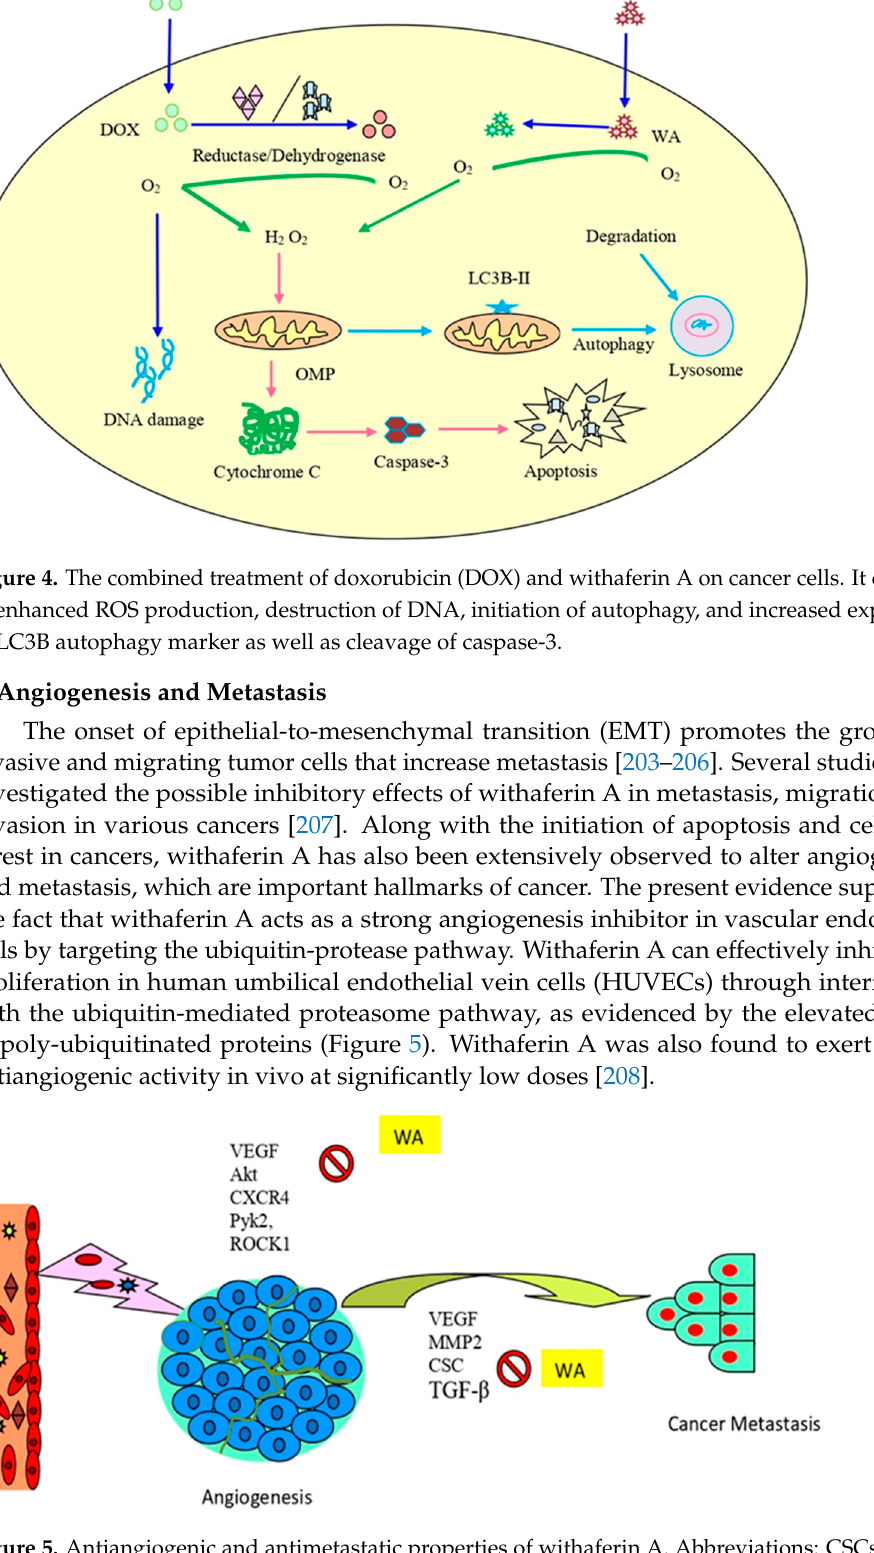
Figure 5. Antiangiogenic and antimetastatic properties of withaferin A. Abbreviations: CSCs, cancer stem cells; CXCR4, C-X-C chemokine receptor type 4; MMP2; matrix metalloproteinases; Pyk2, proline-rich tyrosine kinase 2; ROCK2, Rho-associated coiled-coil-containing protein kinase 2; TGF- β , transforming growth factor- β ; and VEGF, vascular endothelial growth factor.